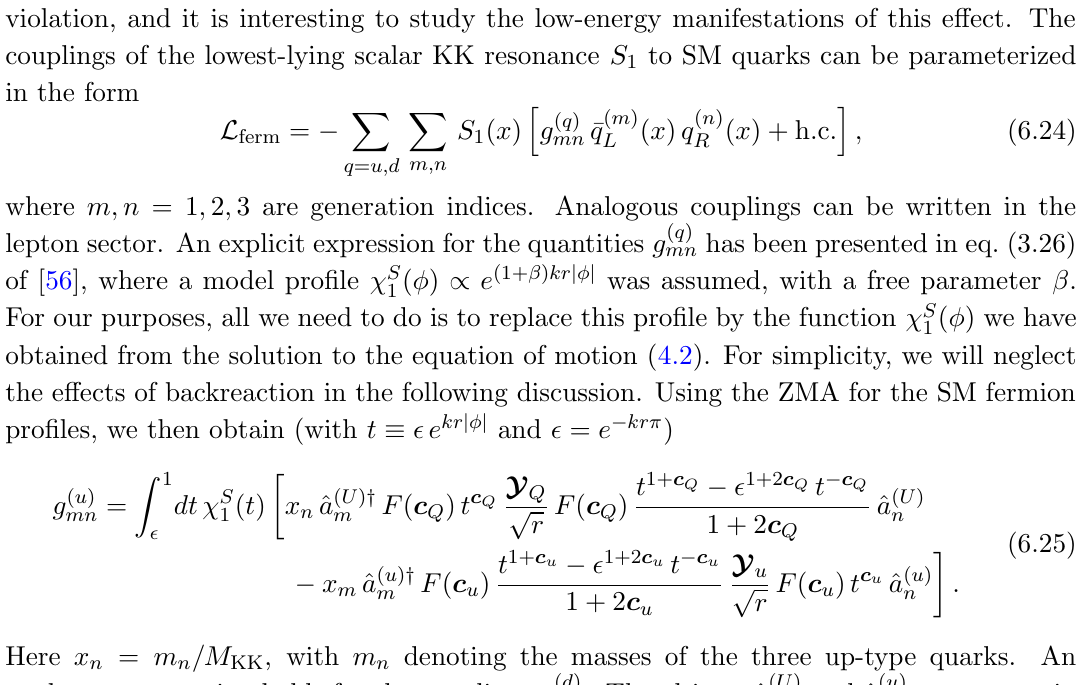
(cid:31) K in the original RS model, and in our model | | = 15 1